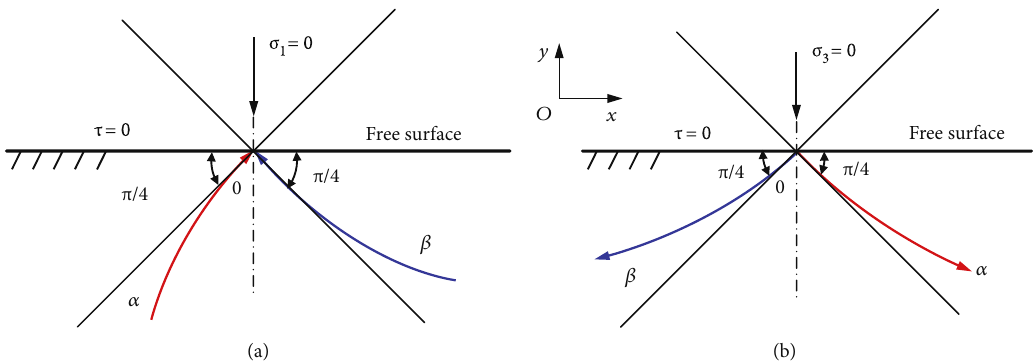
Figure 4: Slip-line characteristics on free surface: (a) compressive stress state; (b) tensile stress state.